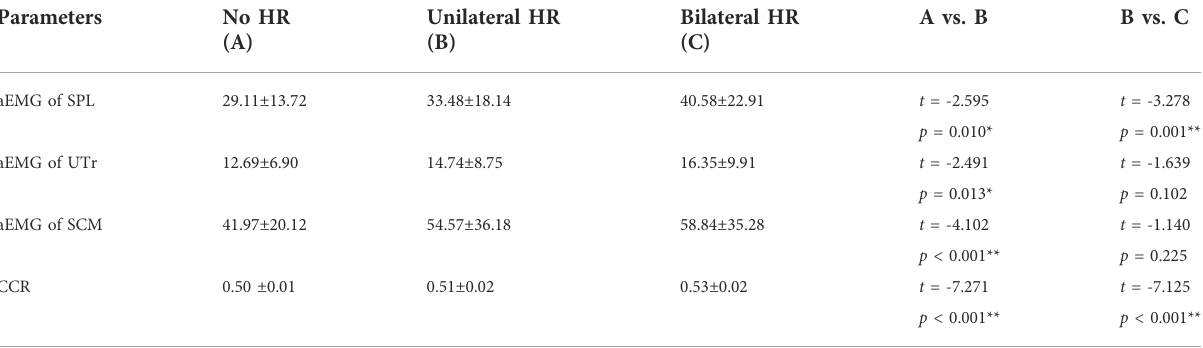
TABLE 2 The aEMG and CCR under no HR, unilateral HR and bilateral HR.